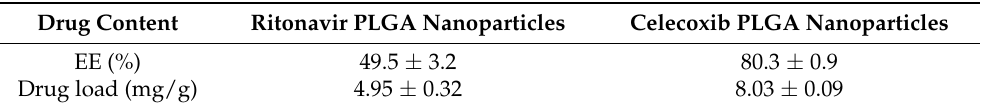
Figure 8. ( A ) Particle size and PDI and ( B ) zeta potential of ritonavir and celecoxib nanoparticles obtained with the inline scaled-up sonication method. Table 8. Ritonavir and celecoxib nanoparticle encapsulation efficiency and relative drug load obtained via the scaled-up indirect inline continuous method.